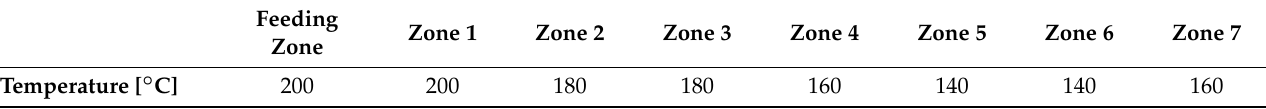
Table 2. Process temperatures of twin screw